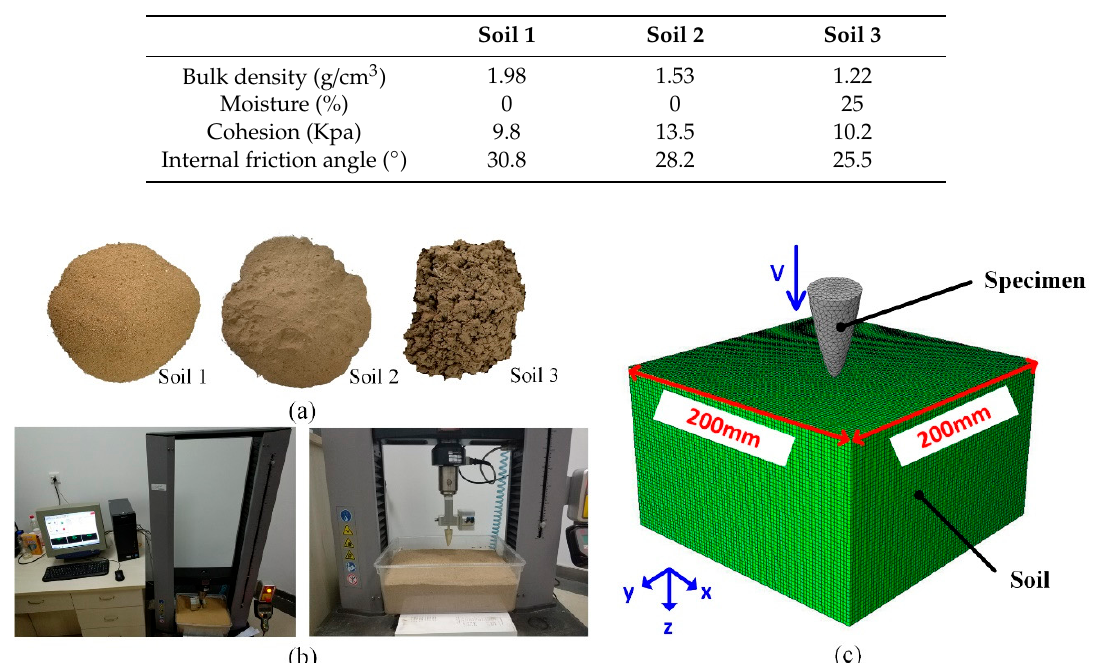
Figure 3. ( a ) The soils used in experiments. ( b ) The devices in experiments. ( c ) The simulation model for analyzing penetration process which was built in ABAQUS.